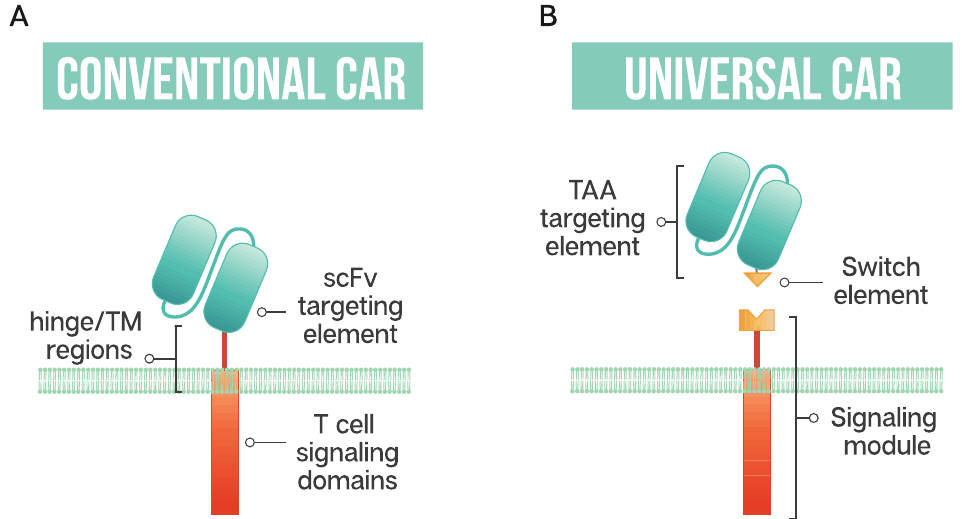
Figure 1. Schematic representation of a conventional CAR T cell and a universal or modular CAR T cell ( A ) Conventional CAR T cells have a single-chain antibody fragment (scFv) targeting element, expressed in tandem with signaling domains derived from the T cell receptor and costimulatory domains such as 4-1BB and CD28 connected through a transmembrane (TM) domain and a flexible spacer or hinge region; ( B ) a universal CAR T cell has a split design containing a tumor-associated antigen (TAA) targeting element, usually derived from a monoclonal antibody, a switch element and the signaling module, consisting of the T cell signaling domains and an extracellular region which interacts with the switch element.